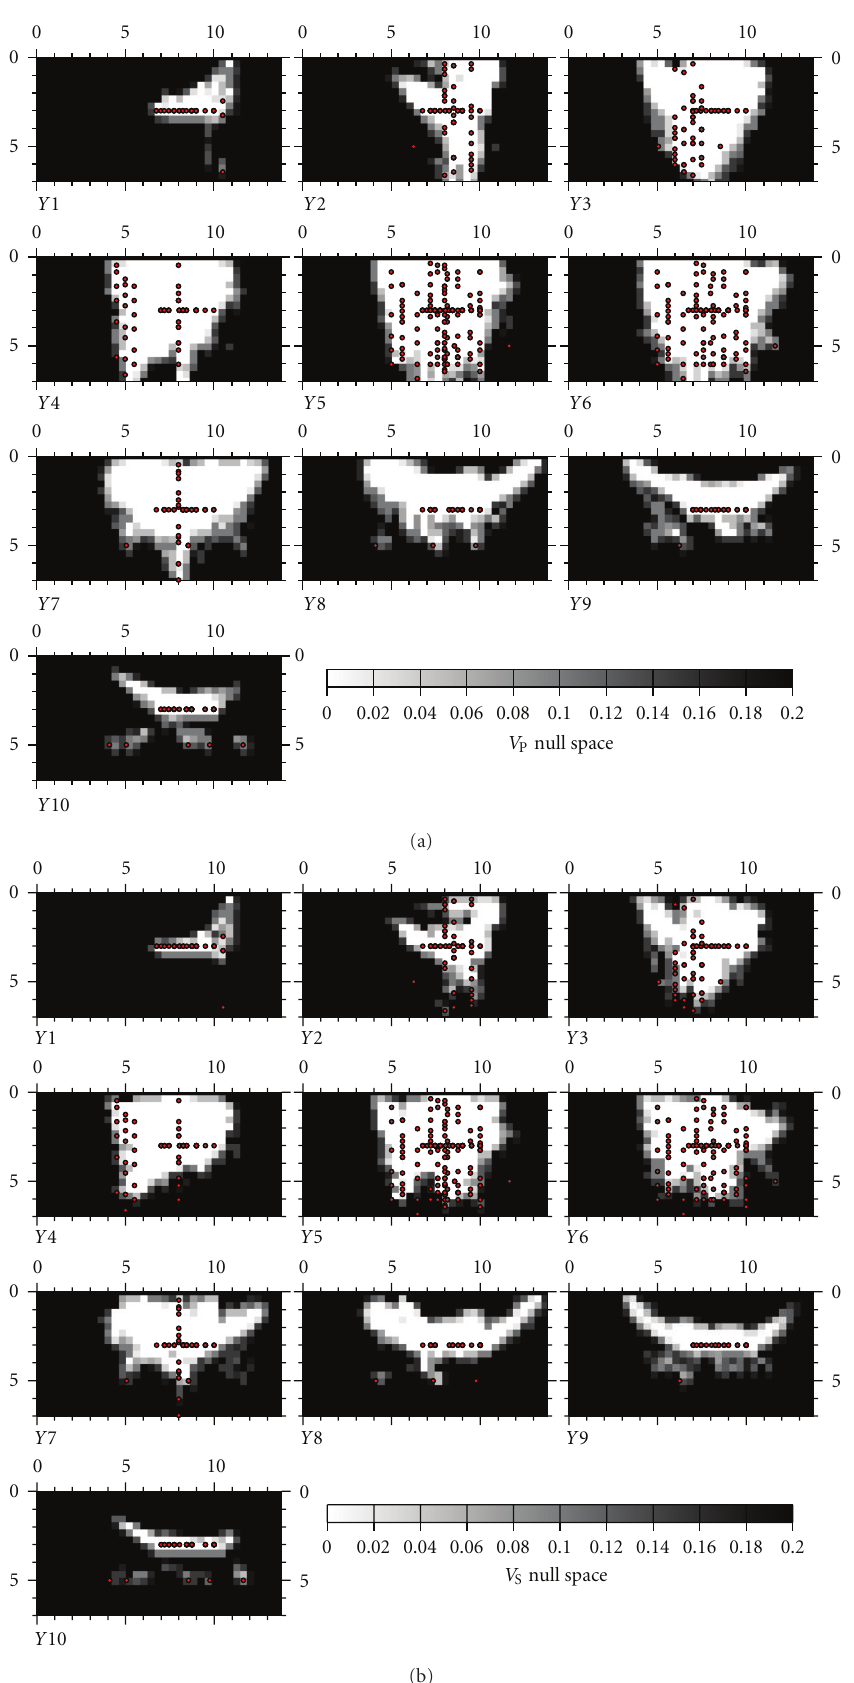
Figure 11: Resolution maps calculated for the true V P (a) and V S (b) models along vertical EW-oriented planes. See text for more